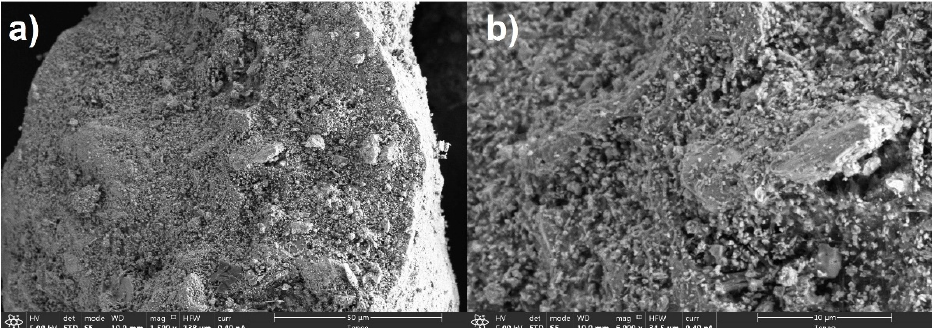
Figure 2. Images obtained of the electric arc furnace slags at different amplifications in the secondary option. ( a ) 1500×. ( b ) 6000×.